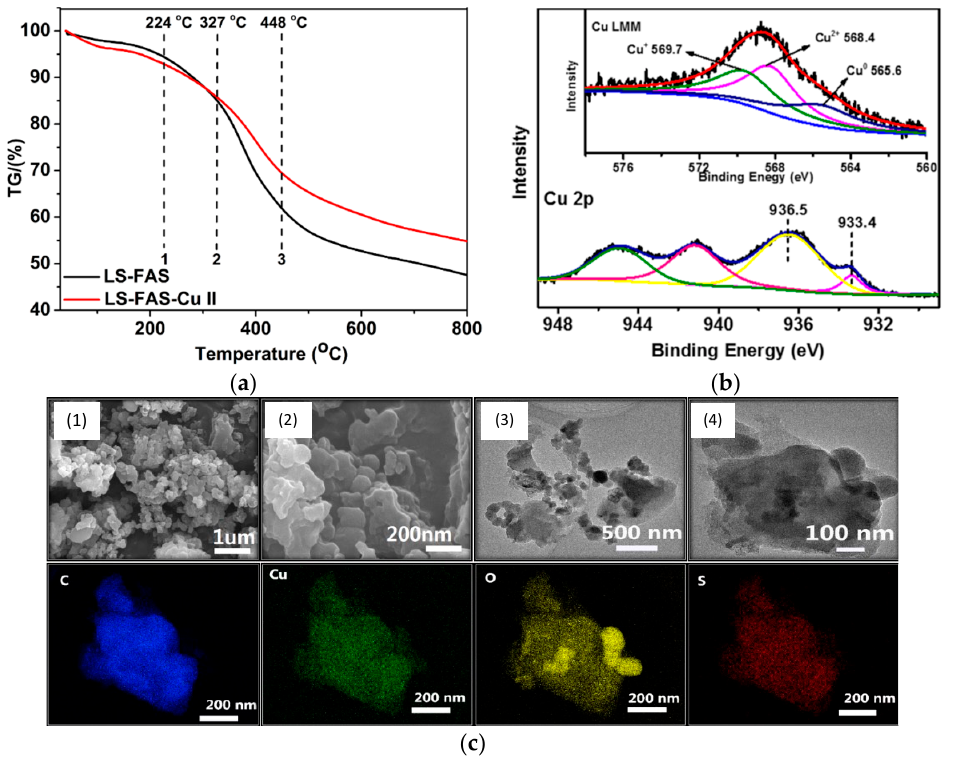
Figure 5. ( a ) Thermogravimetric analysis of the obtained LSA-FAS and LSA-FAS-Cu 2+ . ( b ) XPS spectra of LSA-FAS-Cu 2+ in the Cu 2p 3/2 and Cu LMM regions (inset). ( c ) FSEM images of LSA-FAS-Cu 2+ at different scales (top) and its elemental mapping showing C, Cu, O, and S elements (bottom). Adapted with permission from reference [33]. Copyright 2014 Atlanta Publishing House LLC.